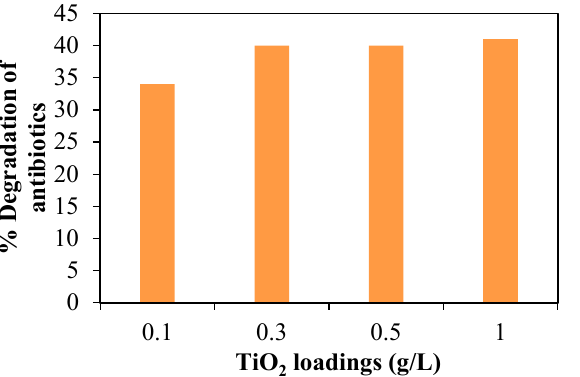
Figure 9. The effect of TiO 2 loadings on the degradation of total antibiotics after 5 min UV illumination at different TiO 2 loadings.